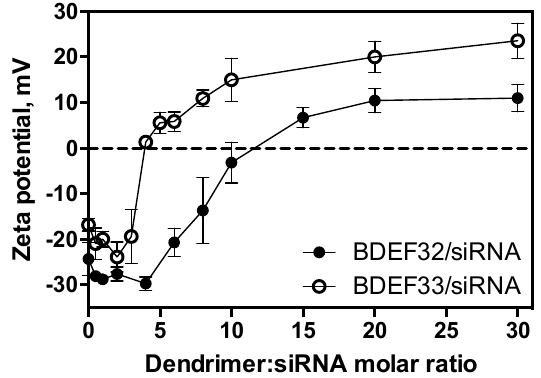
Figure 5. Zeta potential profiles of the dendriplexes (0.5 µM siRNA Mcl-1) as a function of the concentration of carbosilane dendrimers of the second (BDEF32) and third (BDEF33) generation. Conditions: 10 mM phosphate buffer, pH 7.4, 25 °C.